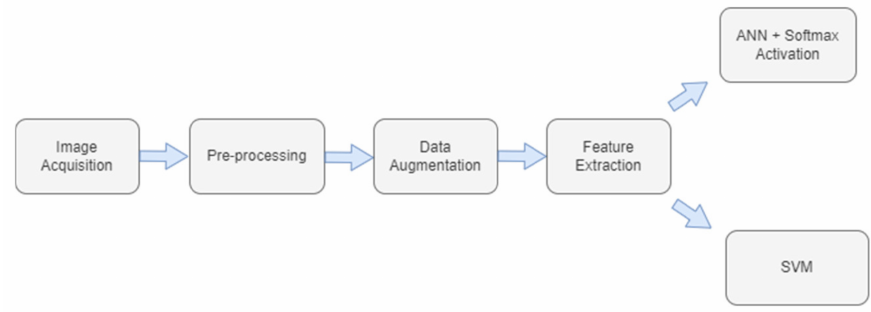
Figure 3. Block diagram.